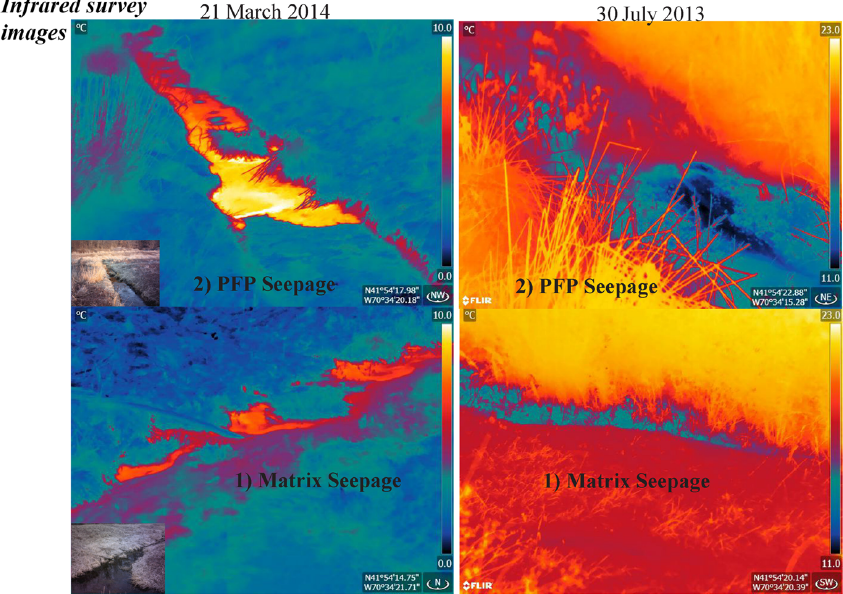
Figure 4. Thermal infrared (TIR) images recorded on 30–31 July 2013 (Summer) and 21 March 2014 (Winter) at Tidmarsh Farms. Visible- light images are shown in the bottom left of March images, but not July, as these surveys were conducted at night to limit issues associated with reflectance. TIR images illustrate the two types of seepage in both seasons: type 1 preferential flow-path seepage that is characterized by discrete discharge points very close to groundwater temperature with high flux, and type 2 matrix seeps that are diffuse and 3–5 ◦ C warmer or cooler than groundwater and lower